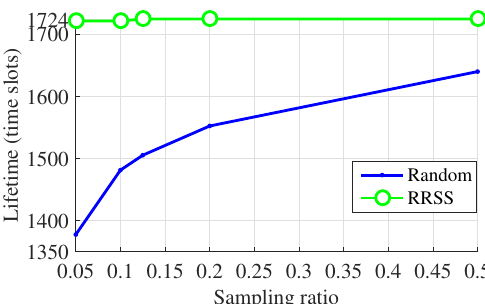
Figure 10. Lifetime over sampling ratio for WSNs from Data-Sensing